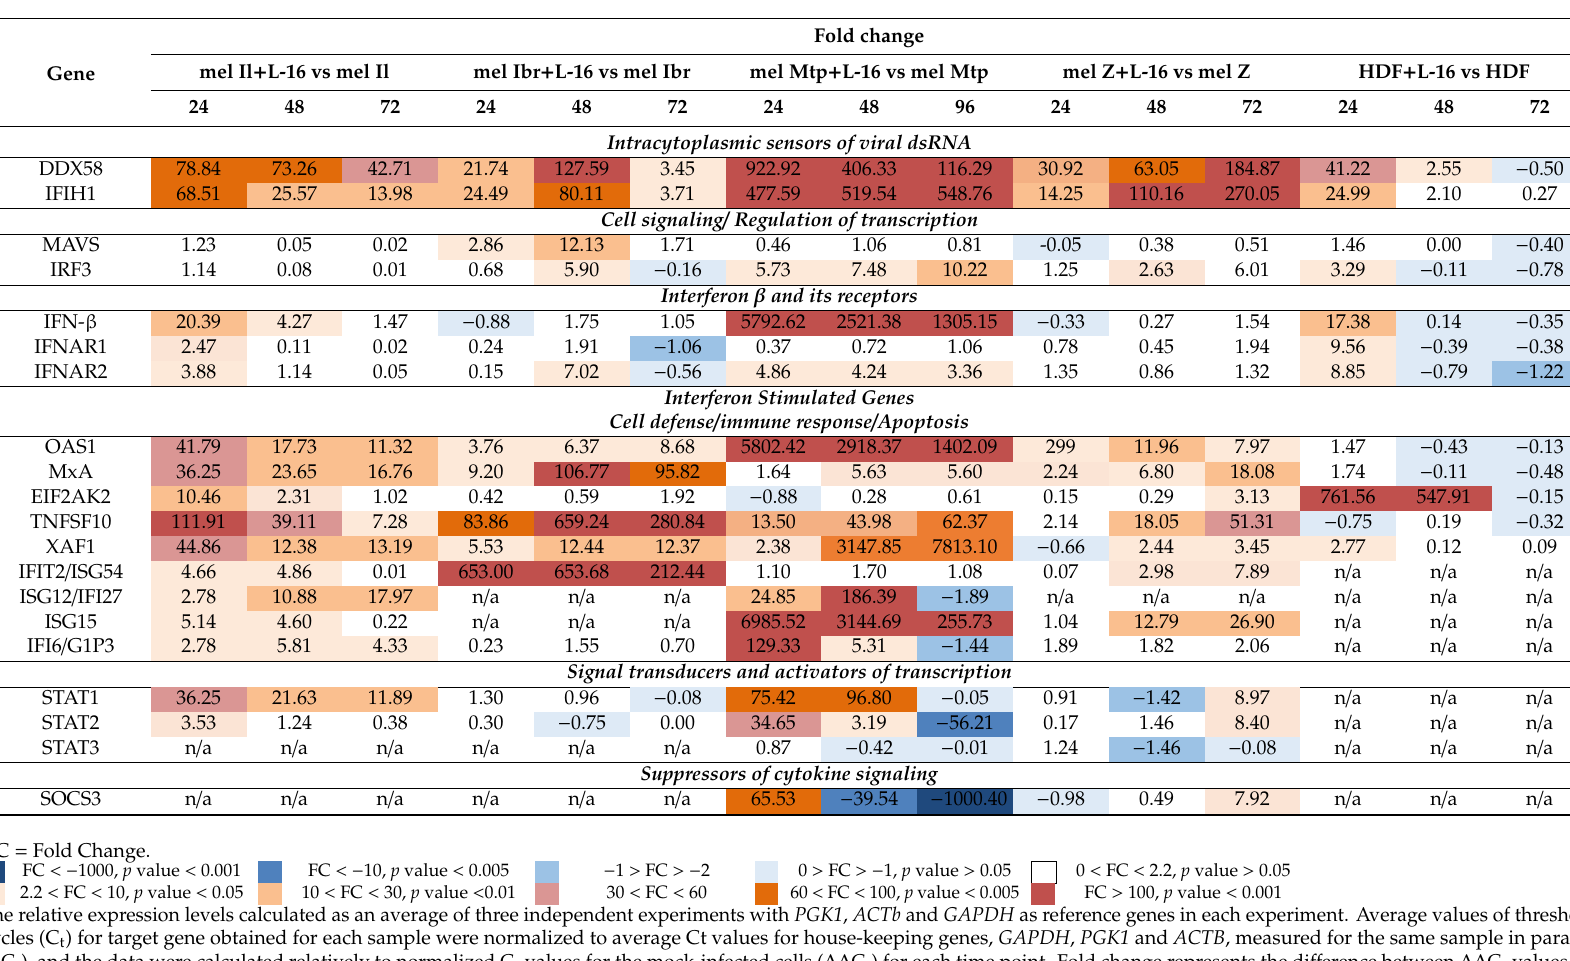
Table 2. Type I IFN and Interferon-stimulated genes (ISG) expression at 24, 48 and 72 / 96 h after infection with MV (MOI =